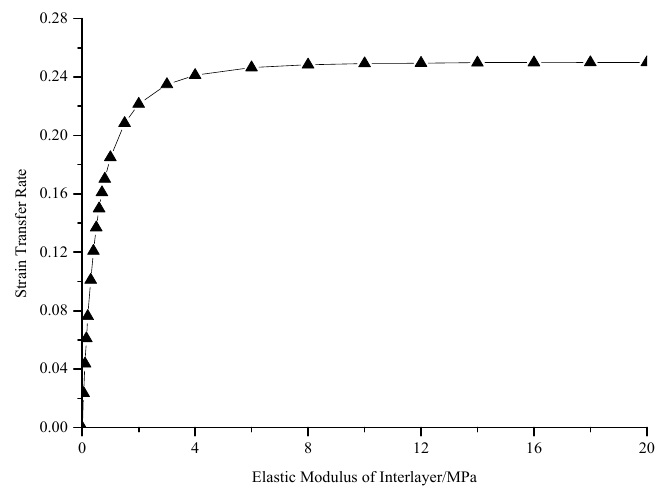
Figure 6. Influence of elastic modulus on strain transfer rate of wide-range FBG sensor.